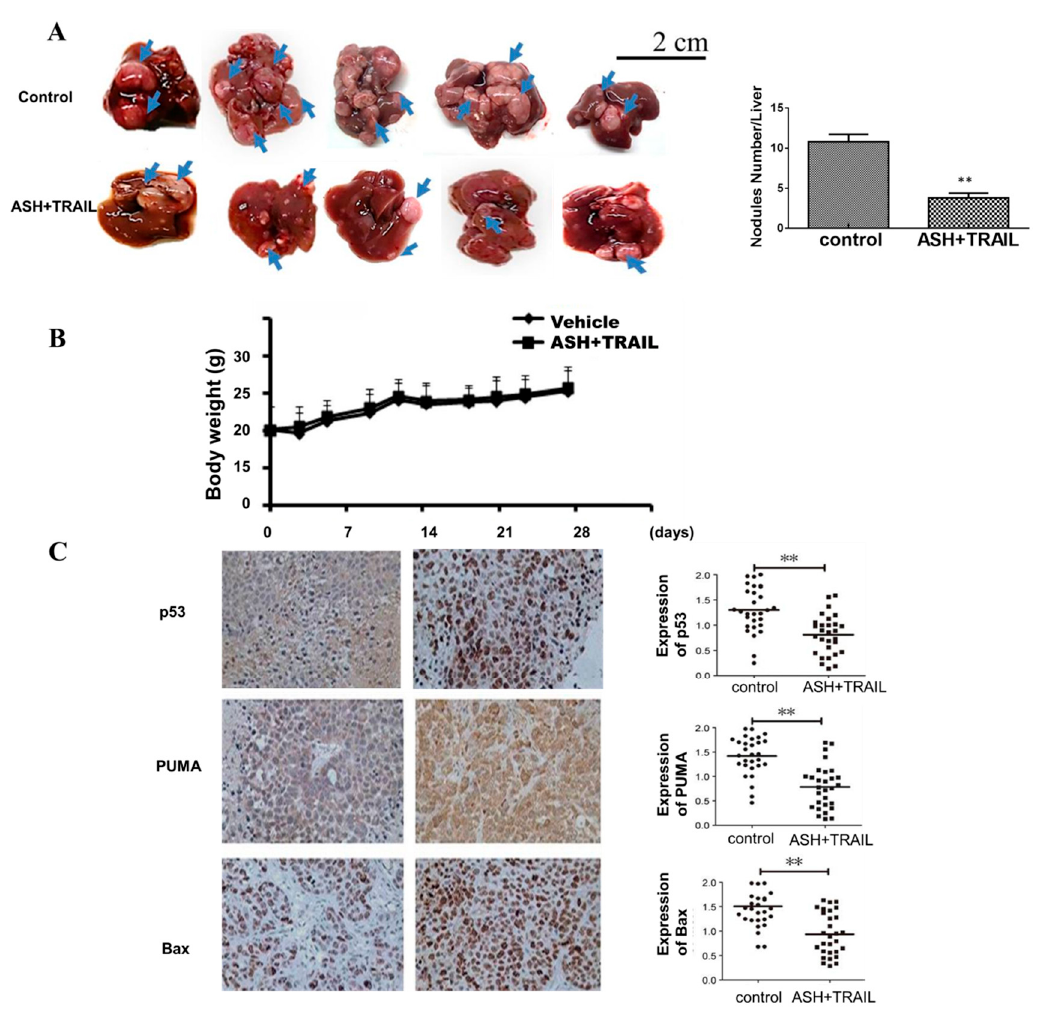
Figure 9. ASH and TRAIL combination treatment inhibits tumor growth in orthotopically